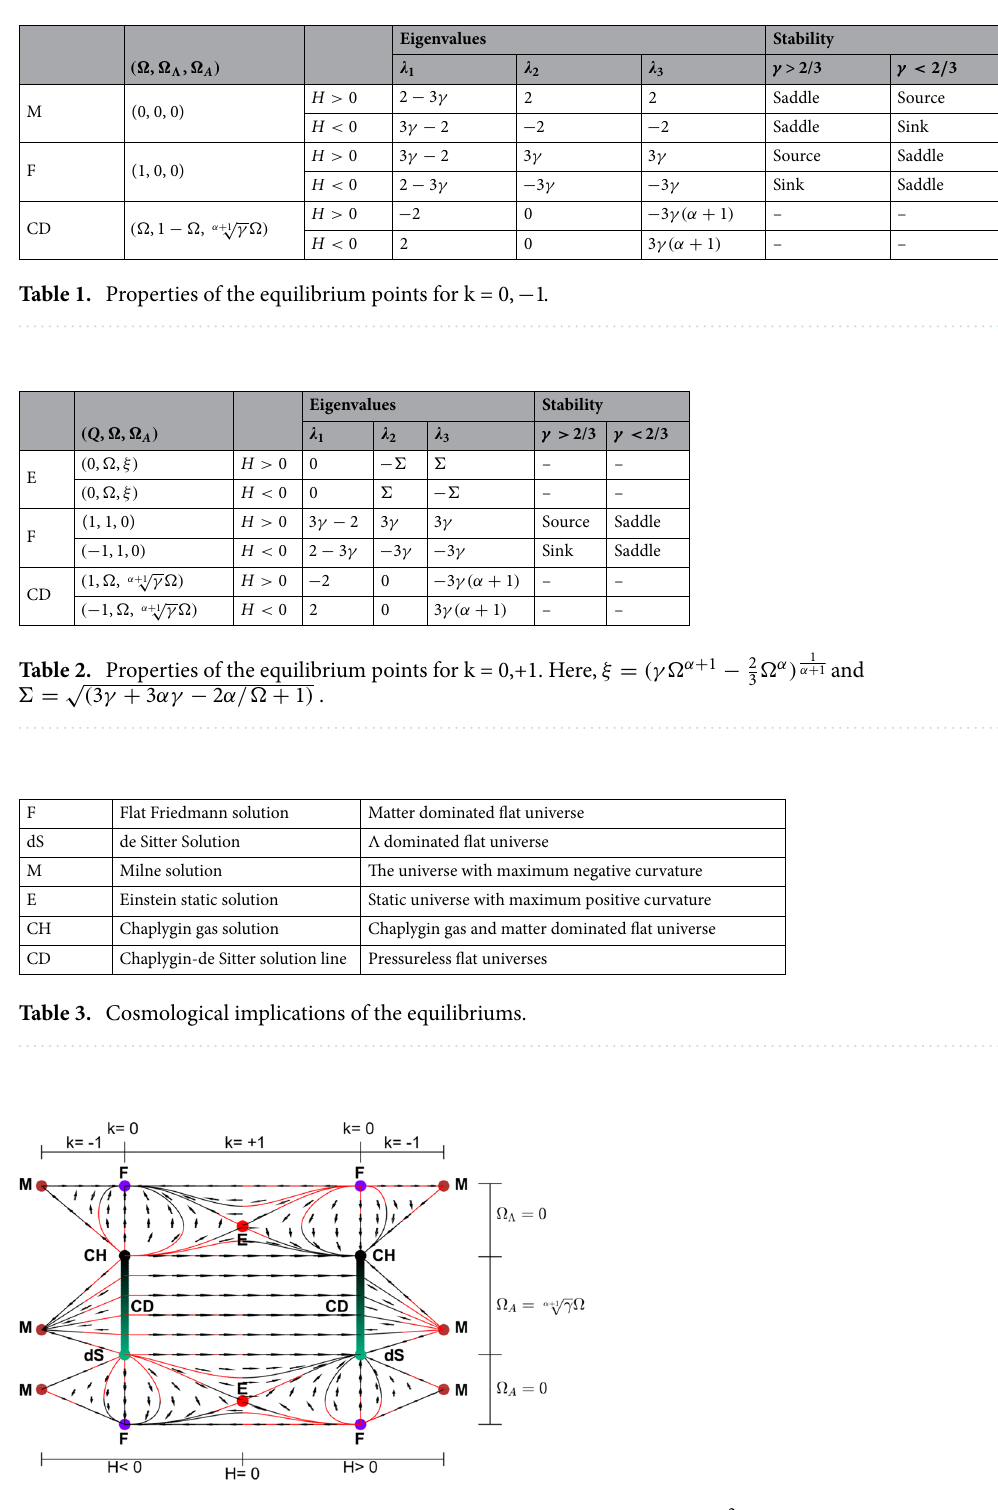
1 and γ > 2 3 . Here, dots denote the = 1, � � 0, � A 0, k 0 ) , = = = = 0, � � 1, � A 0, k 0 ) , Einstein = = = = 1, � � 0, � A 0 ) and Chaplygin-de 1 √ γ , k α + = = = =